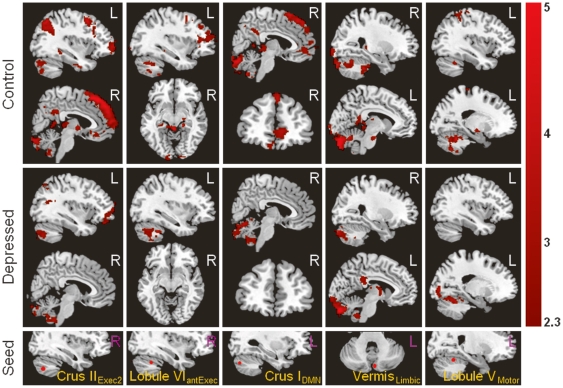
Resting-state functional connectivity of cerebellum seed regions (row five) with cerebral regions from the healthy control group (rows one and two) and depression group (rows three and four).The significant functional connectivity maps shown in each column were computed from the cerebellar seed region shown in the bottom row. The seed regions shown here include: Crus IIExec2, the Crus II region found to be functionally connected with a cerebral executive region (the posterior dlPFC) in previous studies; Lobule VIantExec, the Lobule VI region found to be functionally connected with a cerebral executive region (the anterior dlPFC) in previous studies; Crus IDMN, the Crus I region found to be functionally connected with the default-mode network (mPFC) in previous studies; VermisLimbic, the vermis region found to be functionally connected with a limbic region (ACC); Lobule VMotor, the Lobule V region found to be functionally connected with the motor cortex.